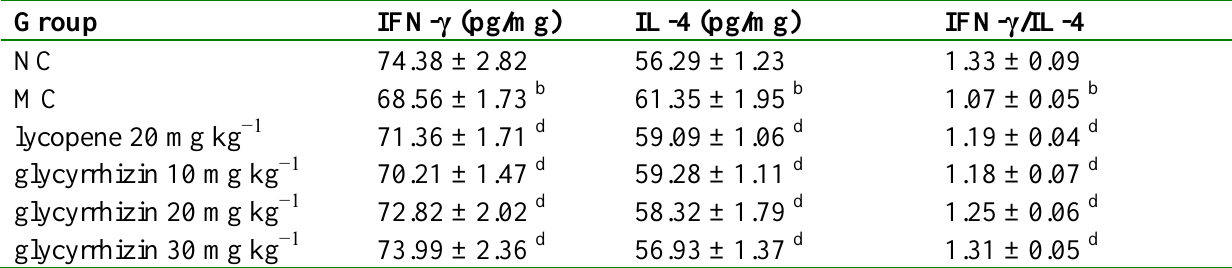
Table 7. Nasal mucosa IFN-γ, IL-4 levels and IFN-γ/IL-4 in different